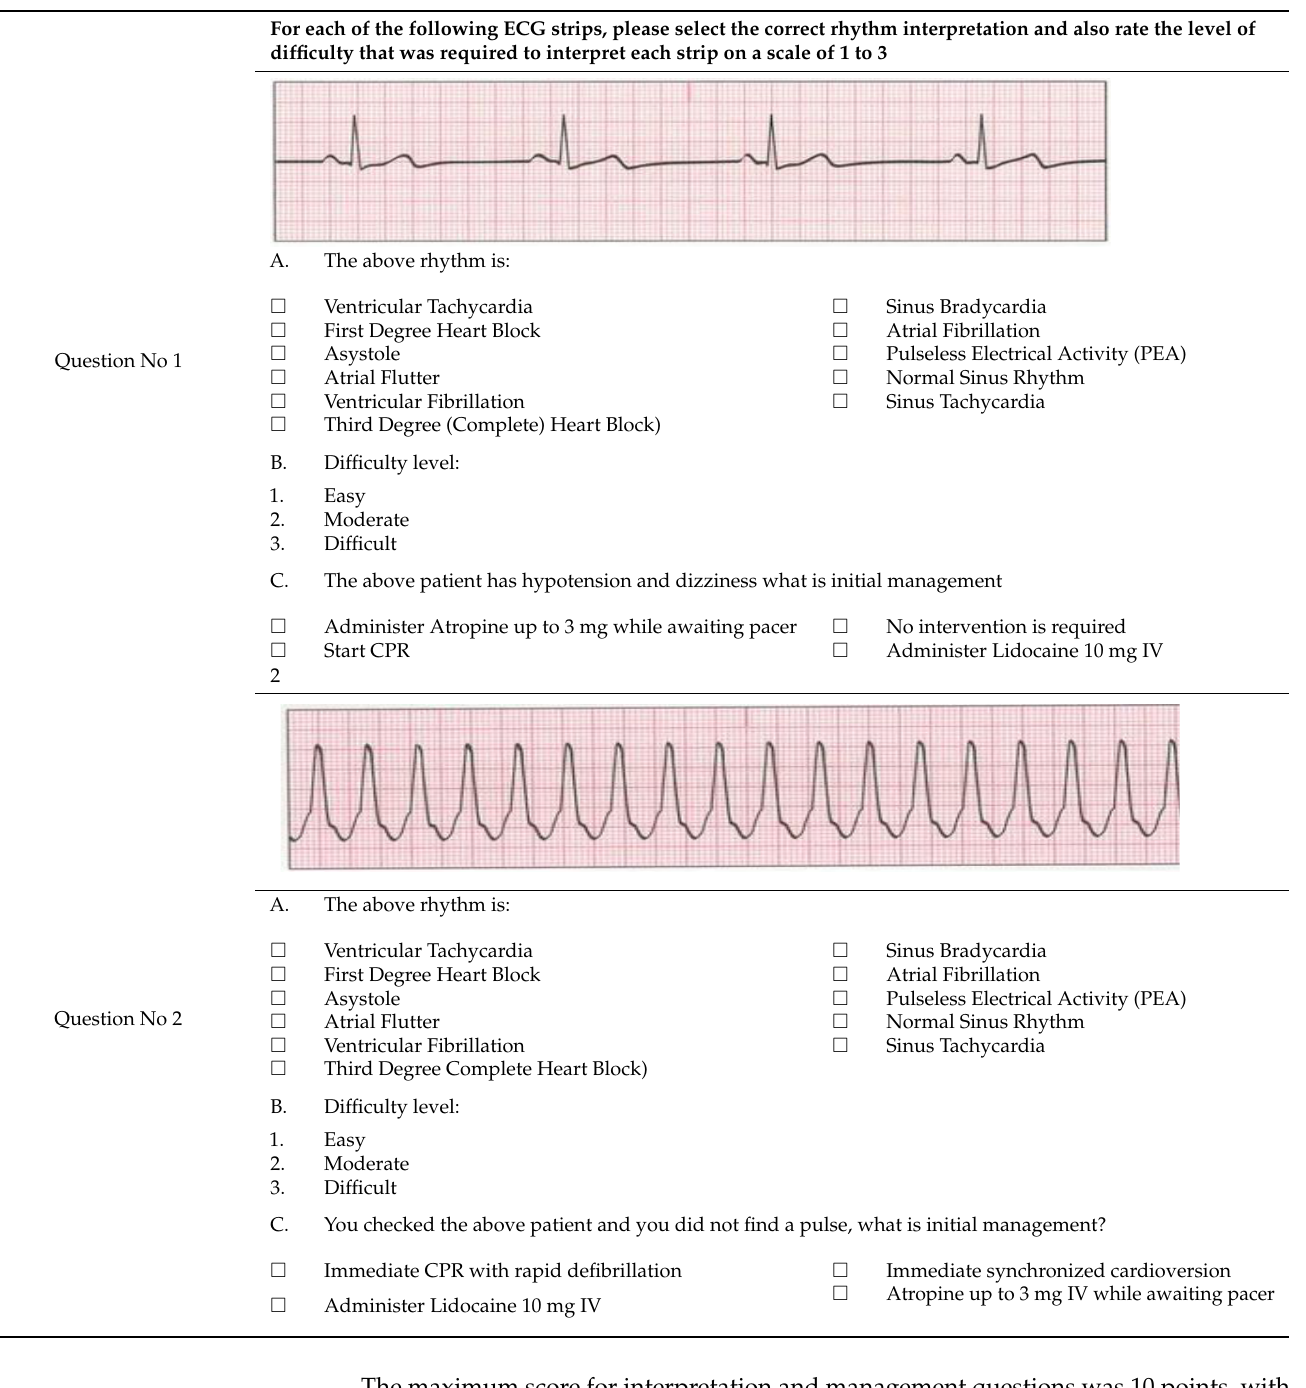
Table 1. Example of the questionnaire questions.